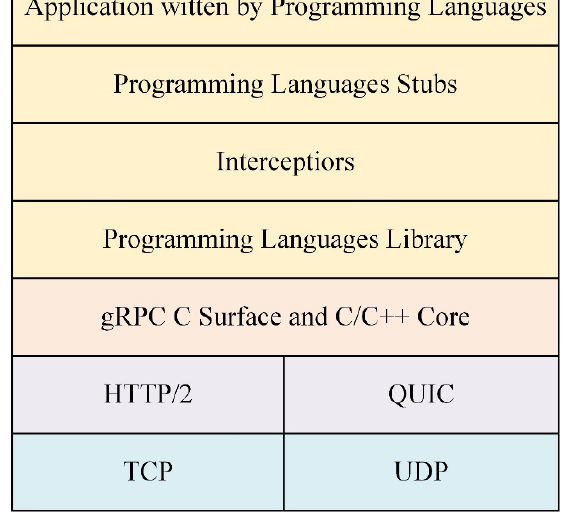
Figure 5. gRPC protocol stack.